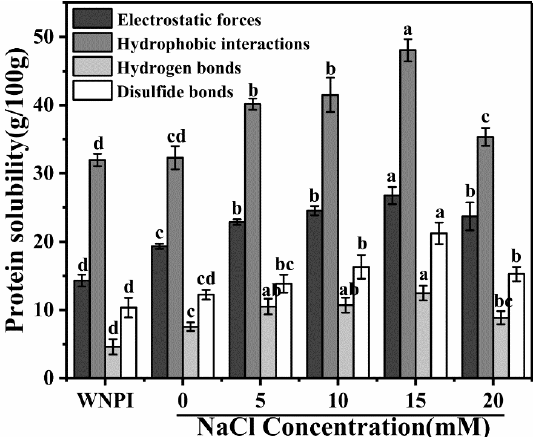
Figure 7. Molecular interaction forces of WNPI-KC composite gel samples with NaCl. Different letters ( a – d ) on differently colored bars indicate significant differences ( p < 0.05).